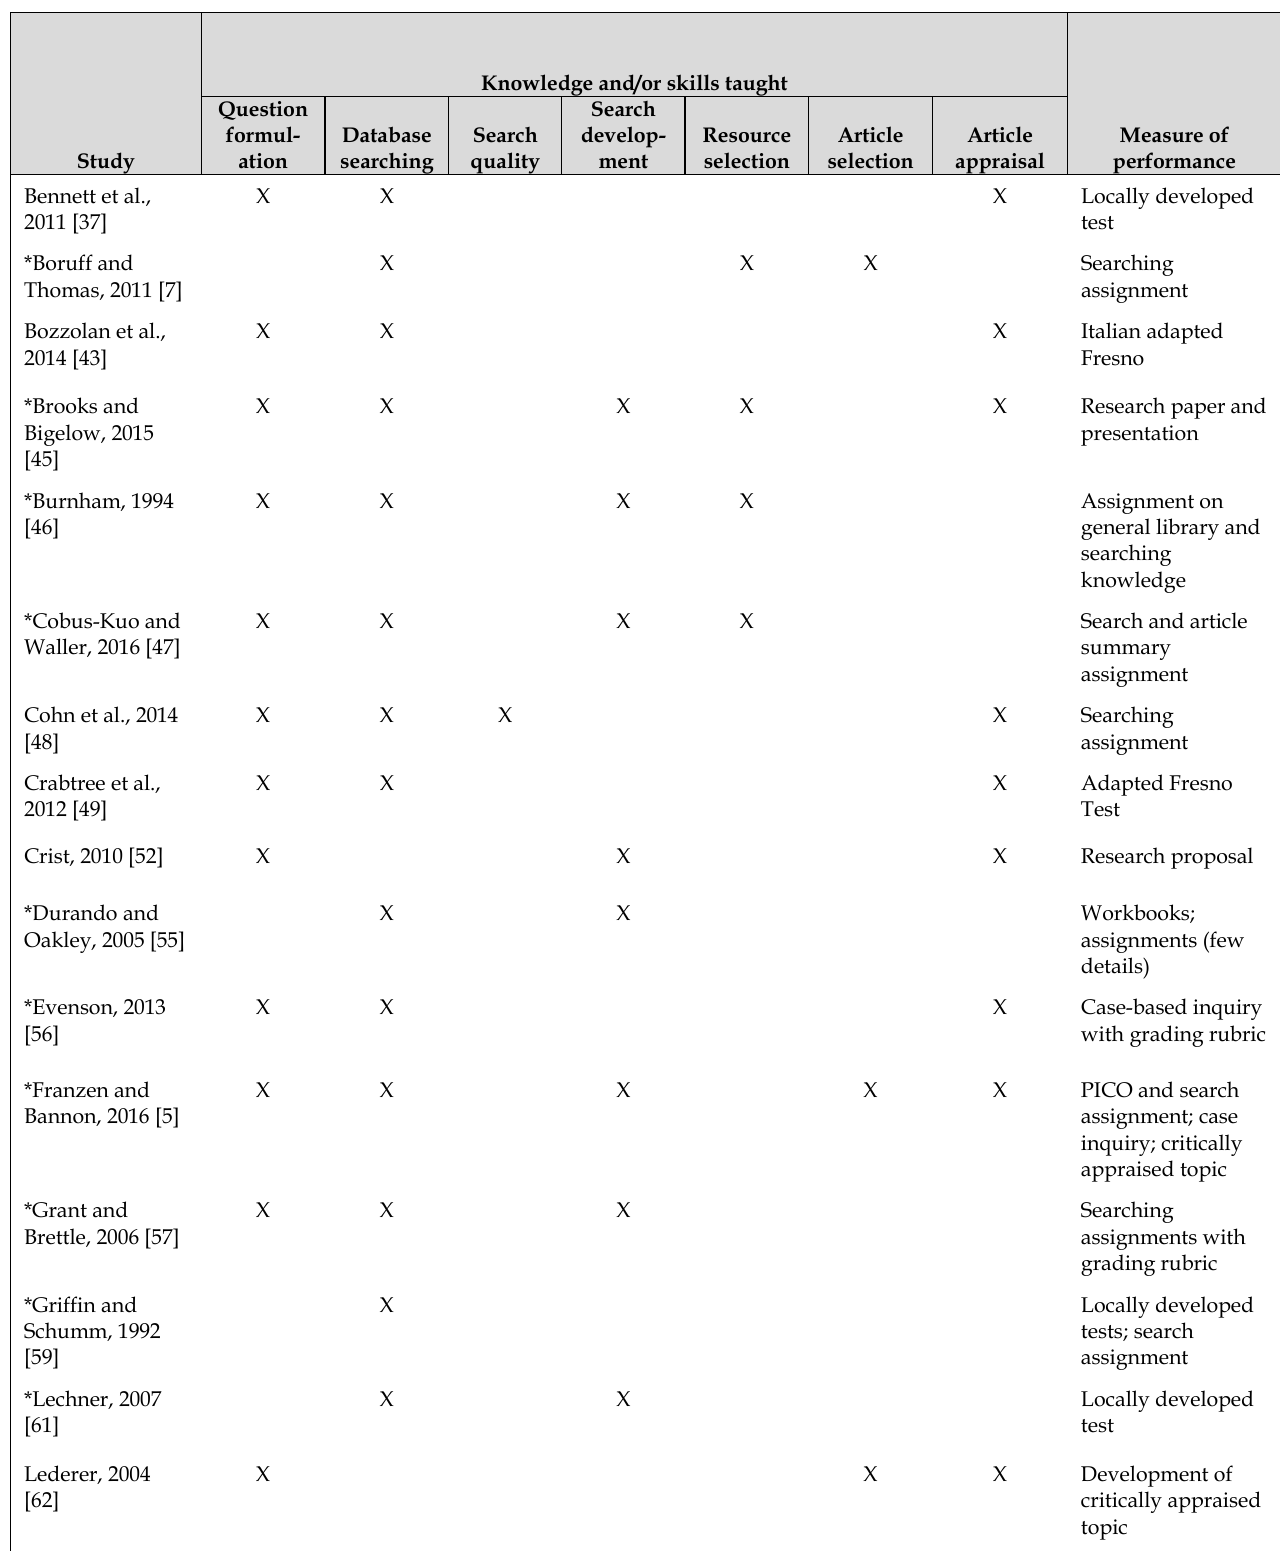
Table 4 Librarian role in the study and assessment measures used